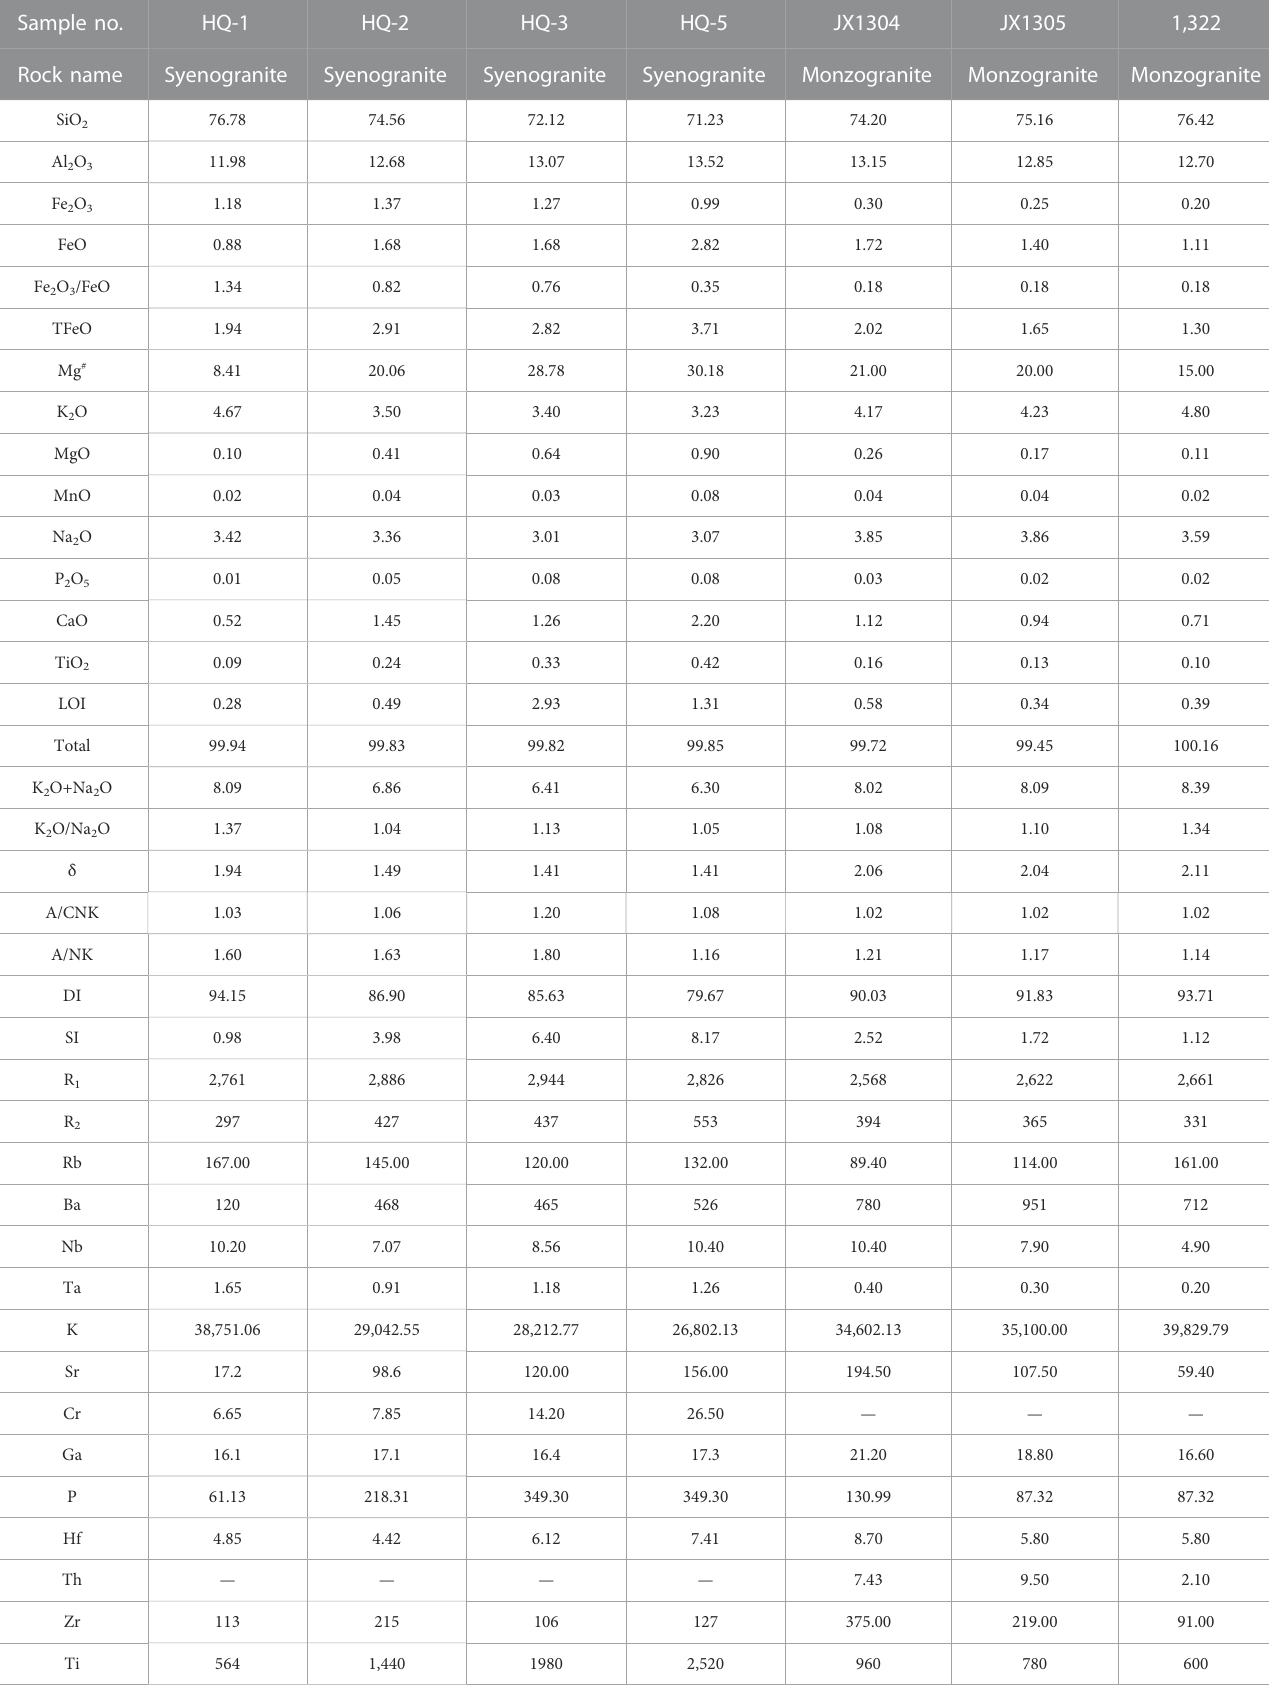
TABLE 2 Analytical results of whole-rock major (%) and trace elements (ppm) for granites in the Xinchenggou area, NE China. Sample